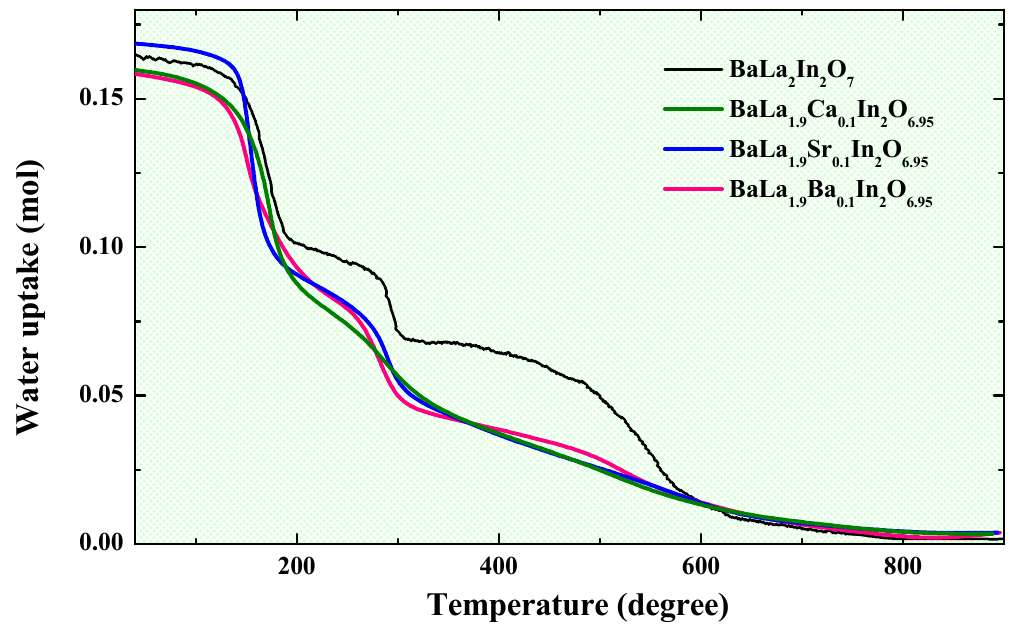
Figure 3. The TG ‐ curves for the investigated compositions. Figure 3. The TG-curves for the investigated compositions. 2.3. Electrical Conductivity Investigations under Dry (pH 2 O = 3.5 × 10 − 5 atm)